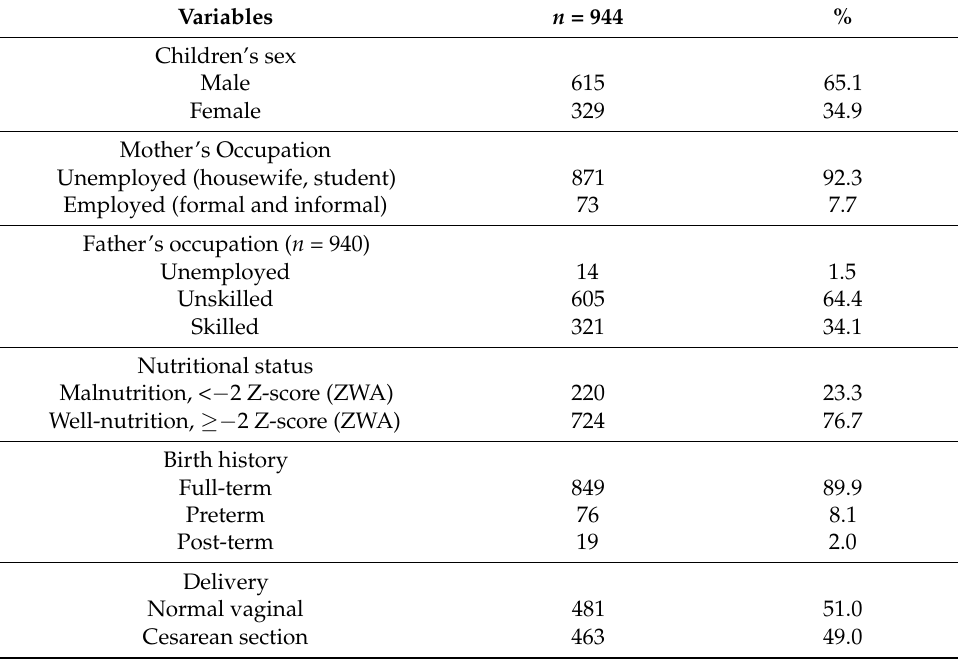
Table 1. Distribution of sex, parents’ occupation, nutritional status, birth and delivery